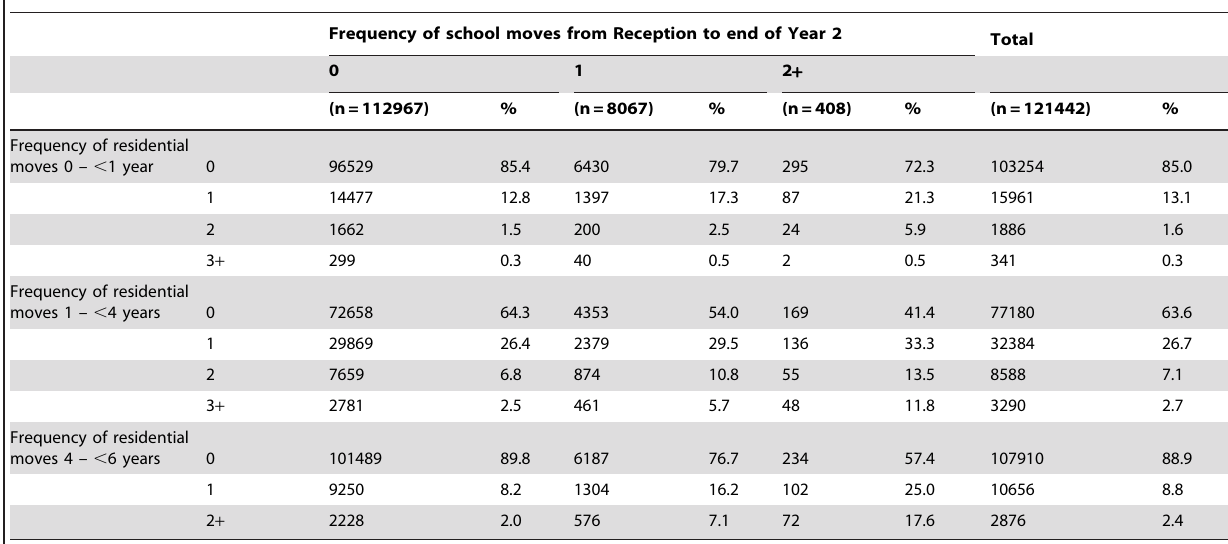
Table 1. Number (%) of residential moves according to school